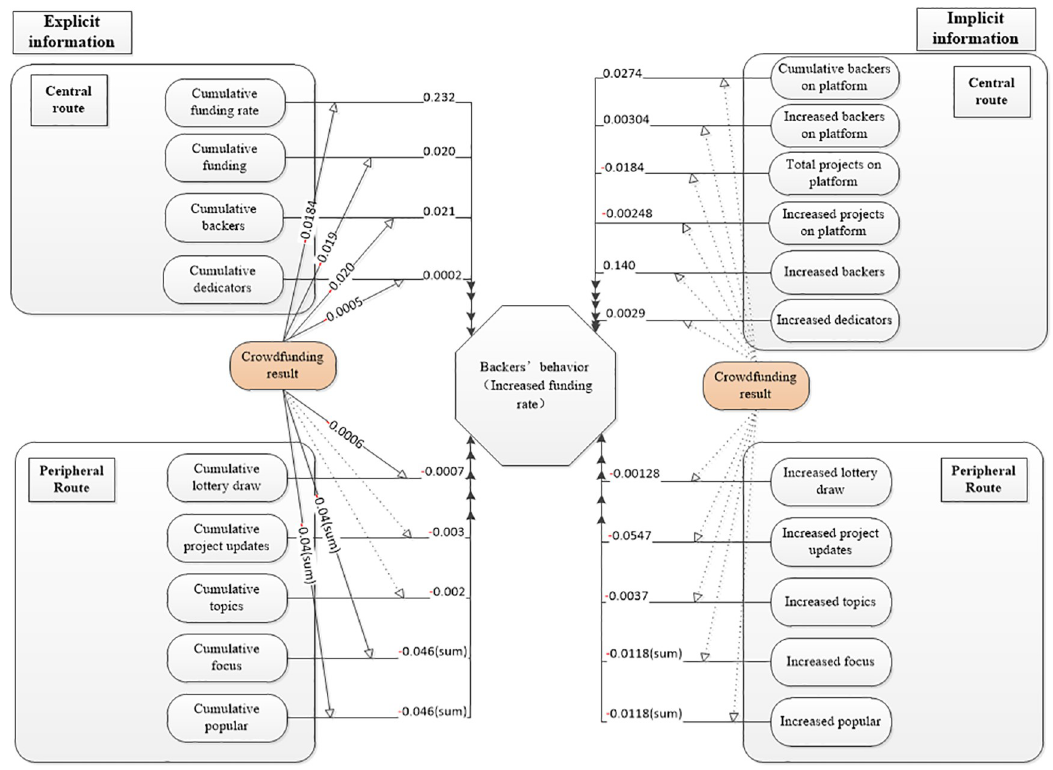
Fig 3. Explicit and implicit variables structure of analysis results. The arrow with dotted line means that there is no moderating effect on the point variable, i.e., P >